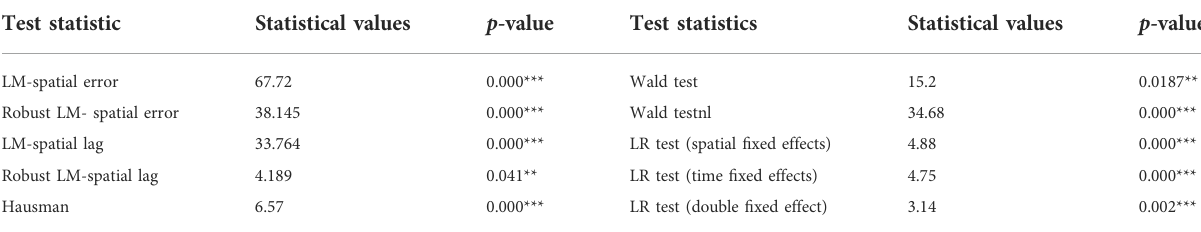
TABLE 5 Estimation results of the spatial econometric model of the business environment and urban – rural income gap. Test